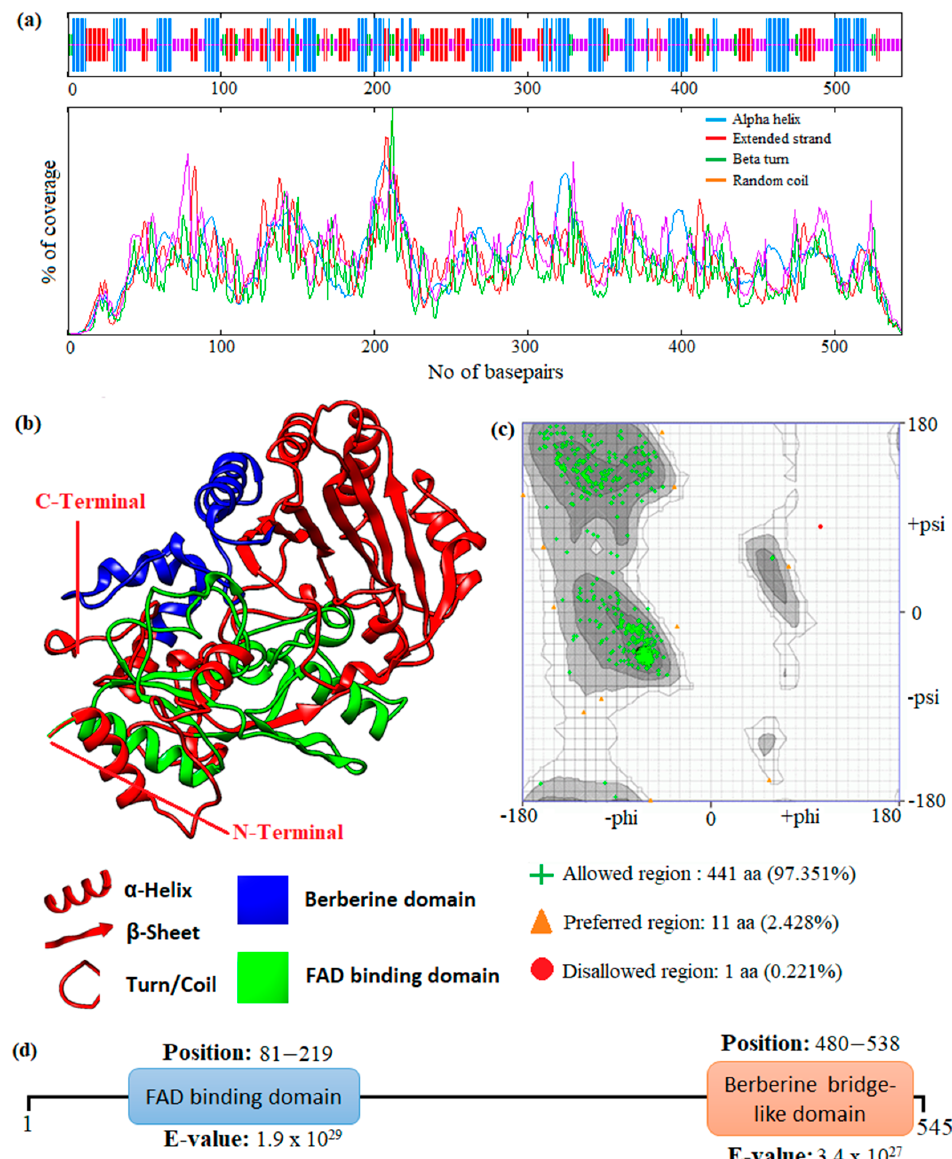
Figure 4. Prediction of the 1D, 2D, and 3D structural profile of Tetrahydrocannabinolic acid synthase. ( a ) Secondary structural elements, ( b ) Predicted 3D model, ( c ) Validated model, and ( d ) Predicted motif and domain regions.